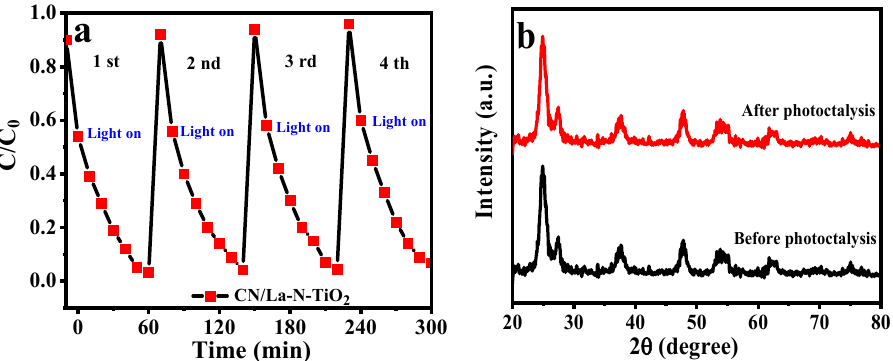
Figure 9. ( a ) Cycling experiment for the CIP removal over CN/La-N-TiO 2 and ( b ) XRD patterns of CN/La-N-TiO 2 before and after the cycling experiment.